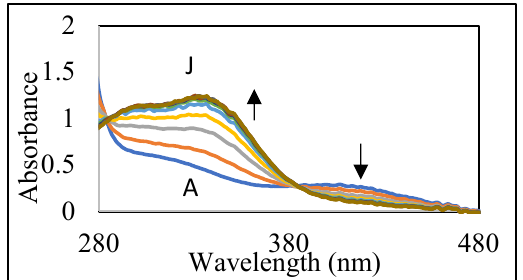
Figure 4. Fate of DBL quinone produced in acetic acid. The reaction conditions are the same as outlined for Figure 3B except for the monitoring the absorbance changes at 10 min intervals instead of 6 sec intervals. Scan A, start of the reaction; Scan J, 90 min reaction.